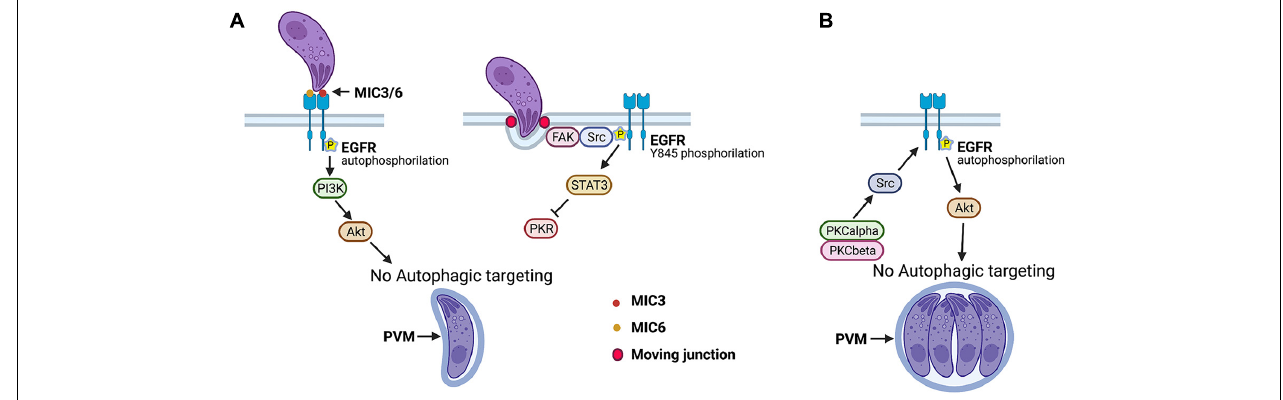
FIGURE 3 | Toxoplasma gondii manipulates host cell signaling cascades that prevent autophagic targeting of parasite. (A) Parasite adhesins MIC3 and MIC6 induce EGFR autophosphorylation that triggers PI3K-dependent activation of Akt, a negative regulator of autophagy. FAK, a cytoplasmic non-receptor tyrosine kinase, is activated during invasion of host cell at level of moving junction. This causes Src-dependent transactivation of EGFR (Y845 phosphorylation) and STAT3 signaling that prevents activation of pro-autophagy proteins PKR and eIF2 α . (B) T. gondii maintains a blockade of autophagic targeting during its intracellular state by activating serine/threonine kinases PKC α /PKC β that in turn maintain Src signaling, EGFR autophosphorylation, and Akt activation. Blockade of any of signaling molecules activated by T. gondii results in autophagic targeting of PV and killing of parasite. This process is dependent on ULK-1, Beclin 1, ATG7, and lysosomal enzymes. Figure was generated using